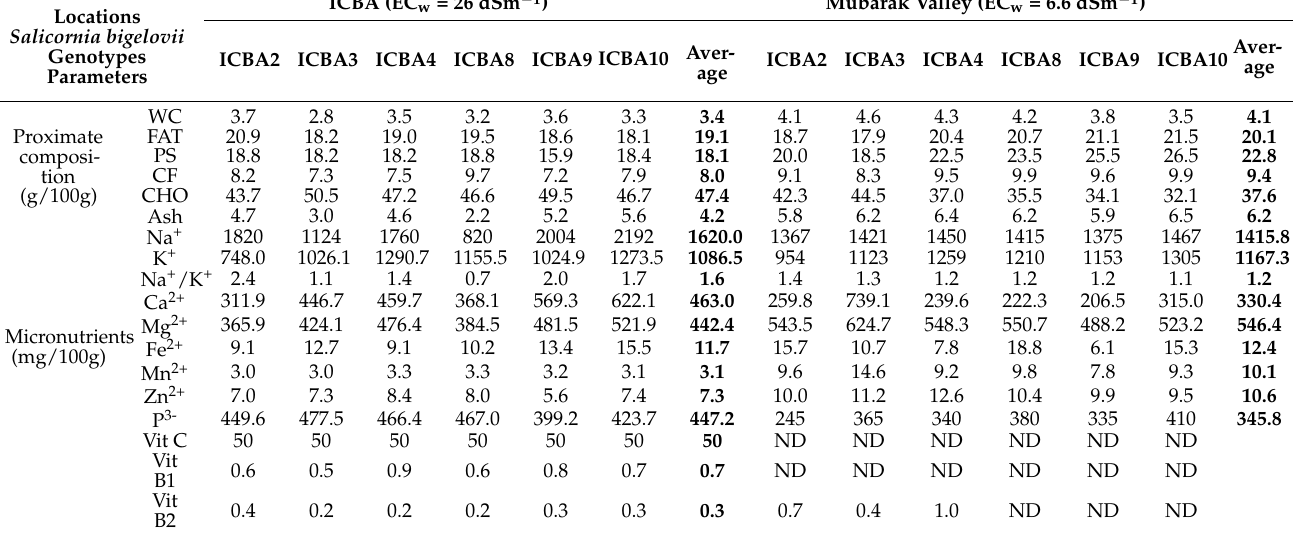
Table A3. Proximate composition (g/100g) and micronutrients (mg/100g) analyzed for seeds of six Salicornia bigelovii genotypes collected at the end of the growing season at ICBA’s experimental station and Mubarak Valley. The average value per parameter from all genotypes was calculated (in bold) for each